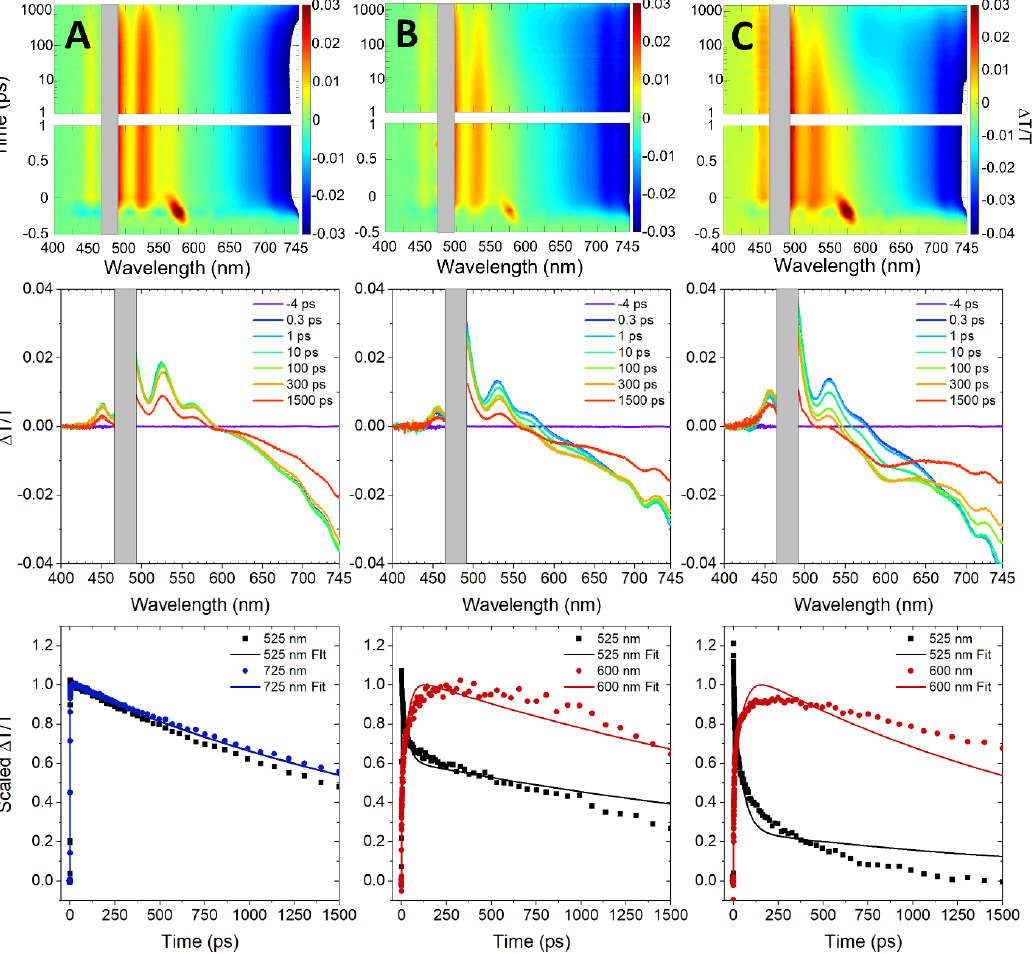
Figure 4. Femtosecond visible transient absorption of DNA-templated perylene monomer, trans- verse dimer, and adjacent dimer solutions excited at 480 nm. The vertical columns correspond to ( A ) monomer, ( B ) transverse dimer, and ( C ) adjacent dimer solutions. Surface plots are on top, selected spectra in the middle, and selected kinetics shown on the bottom. The gray box in the surface plots and selected spectra overlays regions of the spectra contaminated by dynamic pump scatter. The selected kinetics plots correspond to stimulated emission (525 nm) and excited-state absorption features (600 nm and 725 nm) with corresponding fits from global target analysis overlaying the kinetics traces. Table 3. Time Constants Derived from a Global Target Analysis of Femtosecond Visible Transient Absorption of DNA-Templated Perylene Monomer, Transverse Dimer, and Adjacent Dimer Solu- tions.